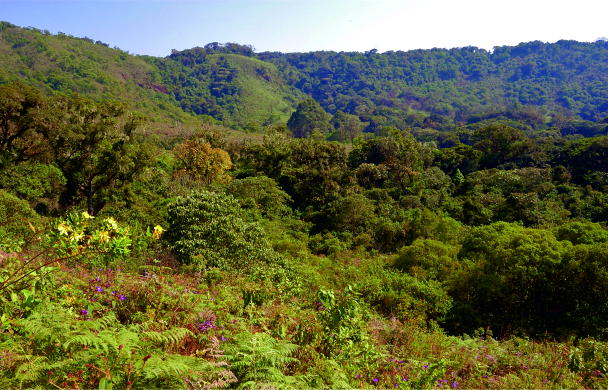
Mosaic of montane forest remnants and open habitats in Mendong Buo (2,200 m a.s.l.).